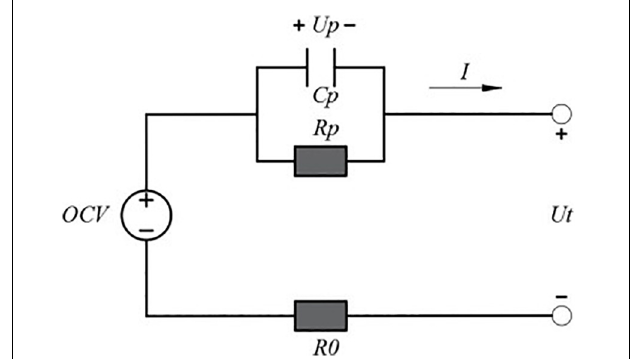
FIGURE 3 | The first-order RC battery